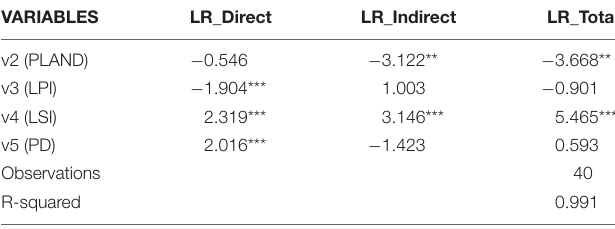
TABLE 6 | Estimation results of agricultural natural